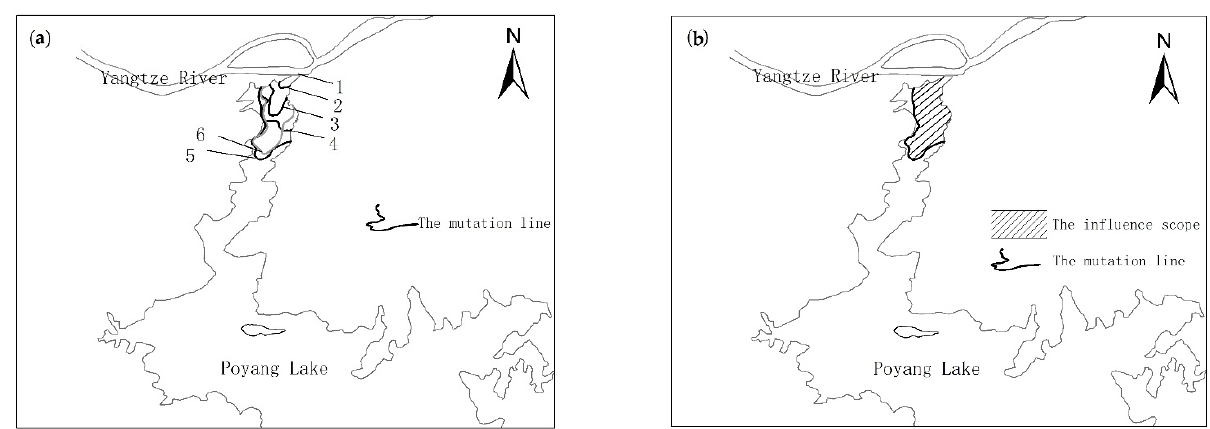
Figure 8. Schematic processing of the backflow from river to lake (BRL) on 7–10 July 2000. ( a ) the processing of the BRL; ( b ) the influence scope of the BRL. Table 1. The observation discharge data of Hukou hydrological station from 7 to 10 July